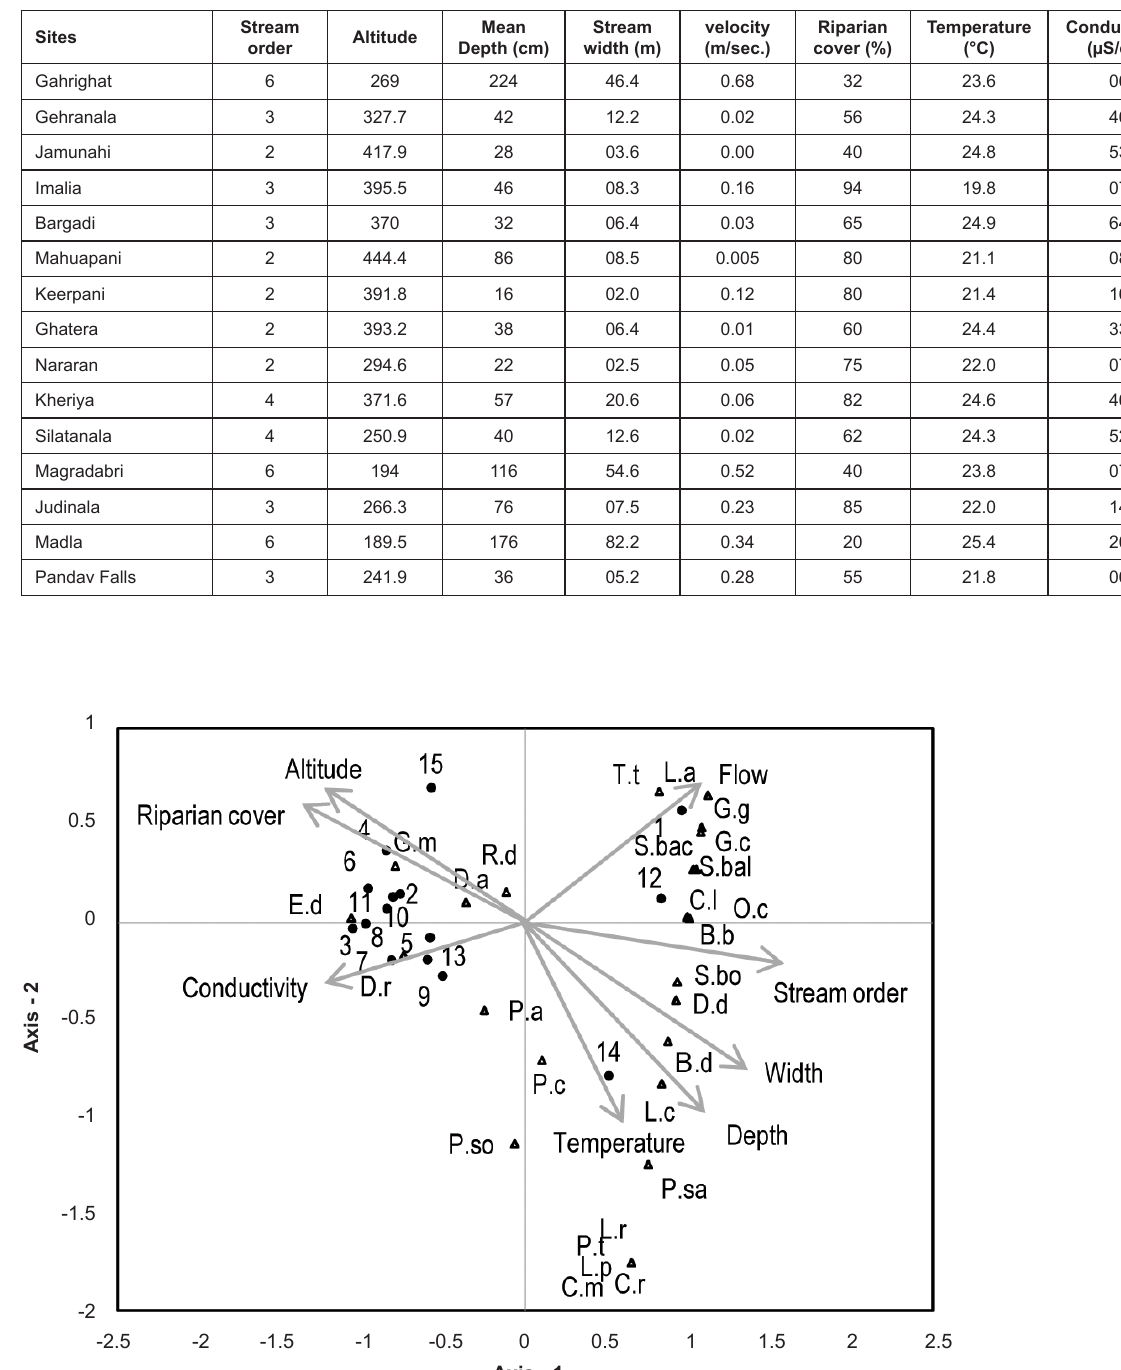
Table 4. Environmental variables of study sites of Ken River basin in Madhya Pradesh